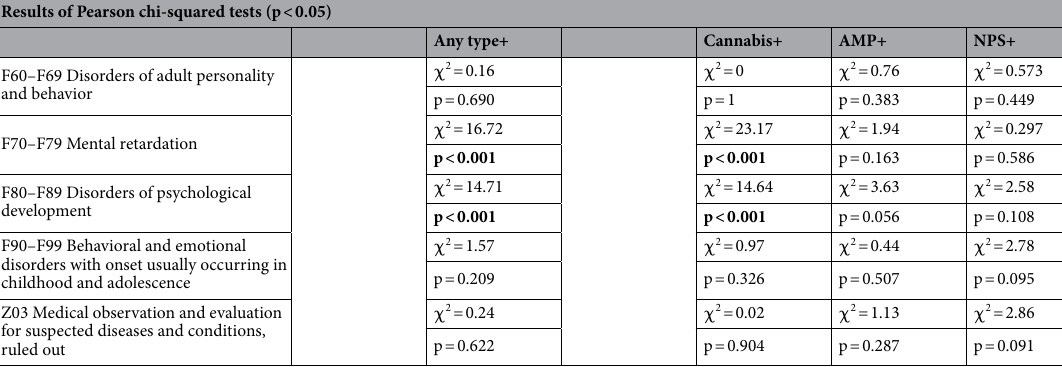
Table 5. Use illicit drugs (ID) according to the psychiatric diagnosis made during the hospitalization. *The total number of all diagnoses is bigger than the total number of members from the examined group because of double and triple diagnoses. Significant values are in bold and